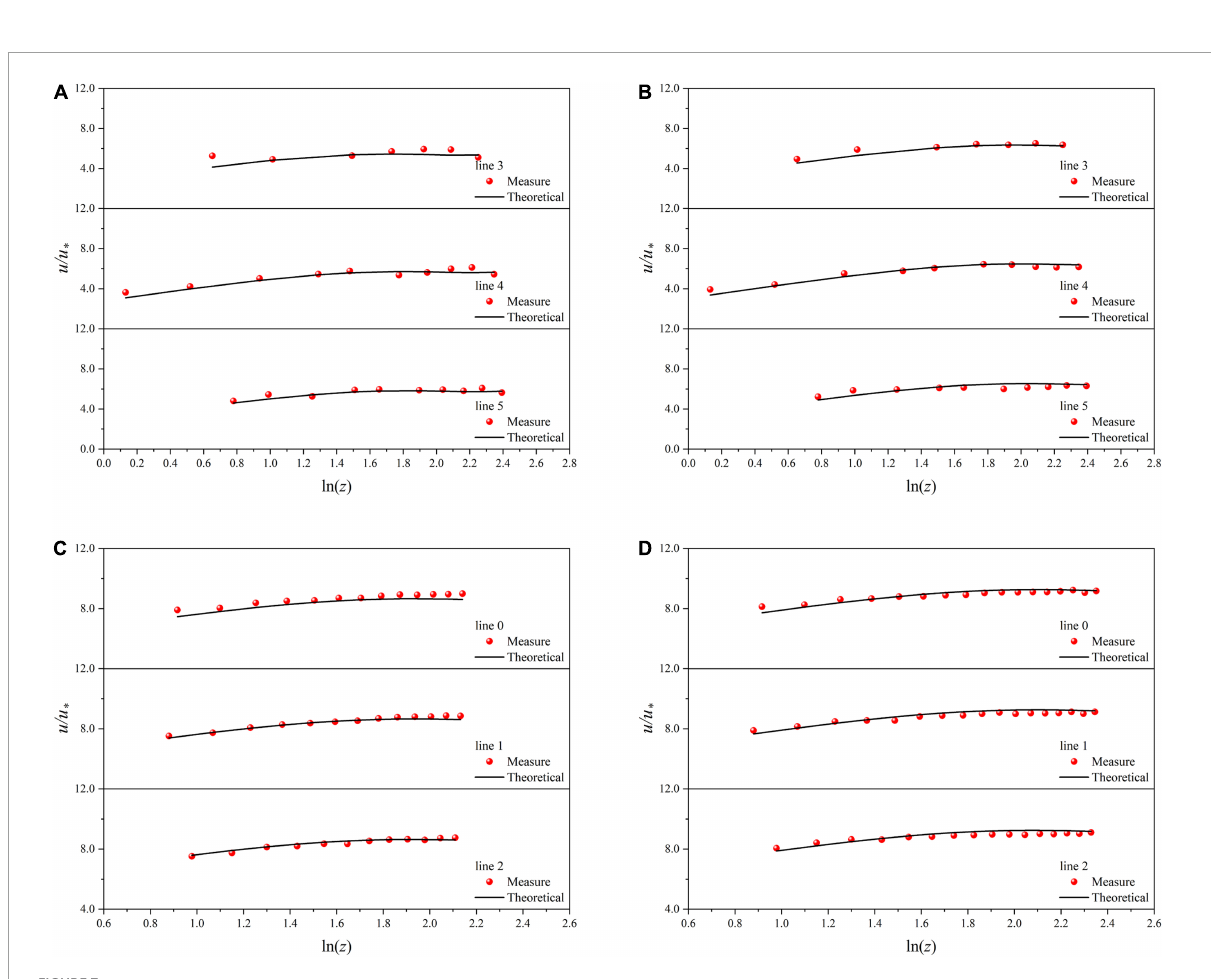
FIGURE7 Velocity distribution along normal line directions in smooth channel. (A) M1, (B) M2, (C) N1, (D)